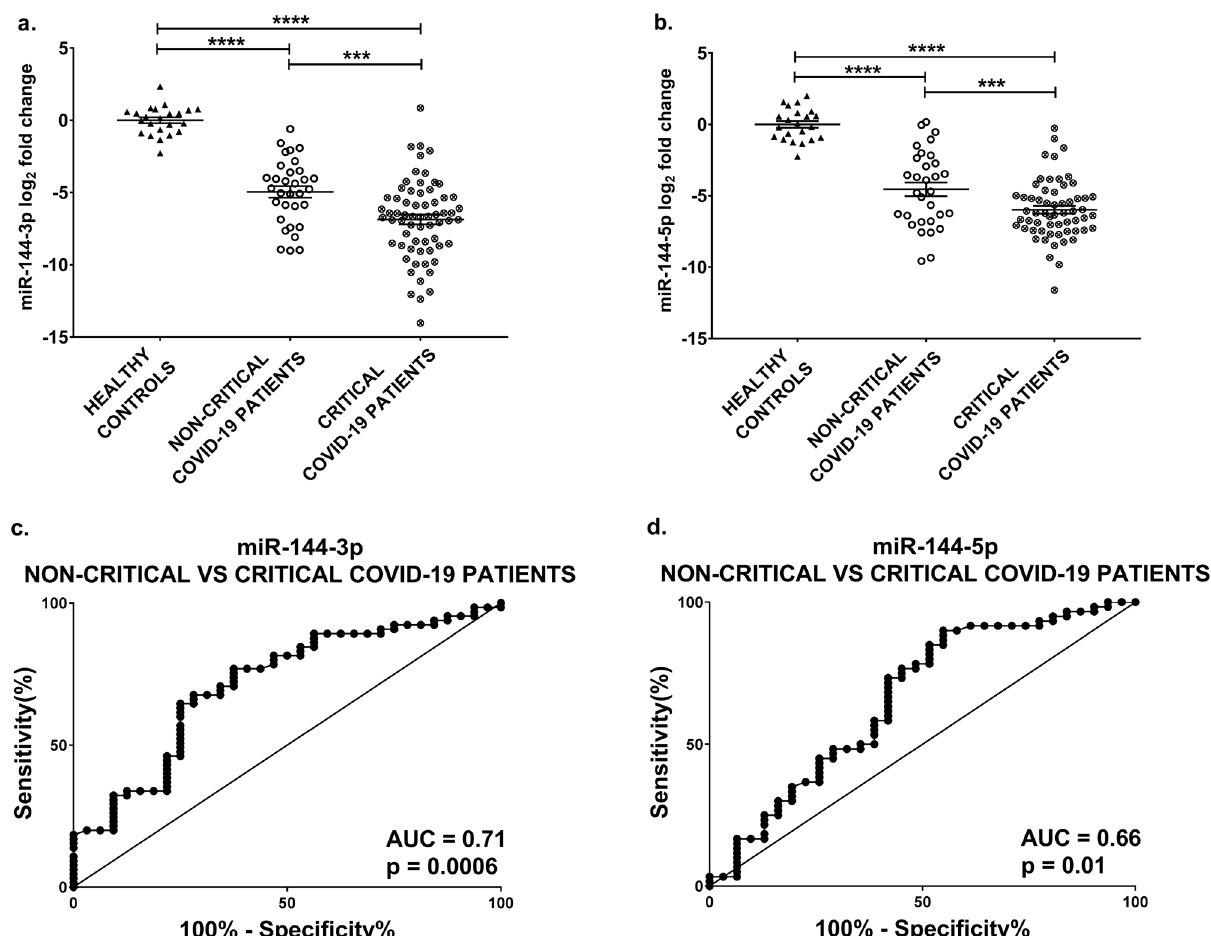
Figure 4. miR-144 levels are decreased in critical COVID-19 patients and discriminate critical from non- critical hospitalized patients. miR-144-3p ( a ) and miR-144-5p ( b ) plasma levels were measured by qPCR in hospitalized patients at PSD and healthy controls. Values are expressed as log 2 fold change compared to controls and shown as dot-plots indicating mean ± SEM. Both miR-144-3p and miR-144-5p expression levels decreased in critical compared to non-critical patients. ANOVA test, followed by Tukey’s post-hoc test, was performed for statistical comparison. The ROC curves show the sensitivity and specificity of miR-144-3p ( c ) and miR-144-5p ( d ) to distinguish non-critical from critical COVID-19 patients. Controls n = 23; non-critical patients n = 31–32; critical patients n = 60–65; *** p ≤ 0.001; **** p ≤